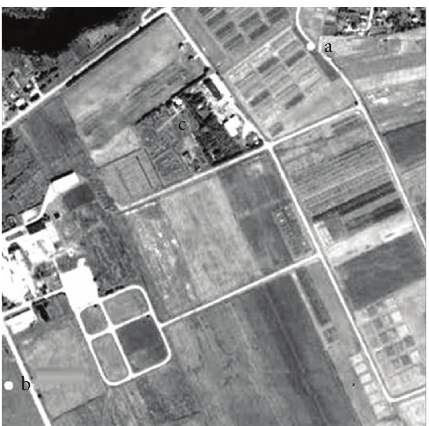
Figure 1: Study sites: (a) seminatural grassland (54 ◦ 88 (cid:3) N, 23 ◦ 84 (cid:3) E) and (b) intensively managed cultural pasture (CP); (c) Kaunas Meteorology Station (54 ◦ 87 (cid:3) N, 23 ◦ 83 (cid:3) E) (LUA, Research Station; LTD BK 50000-VNˇZT, 2004, HNIT-BALTIC GIS, 2005; M 1:50000).